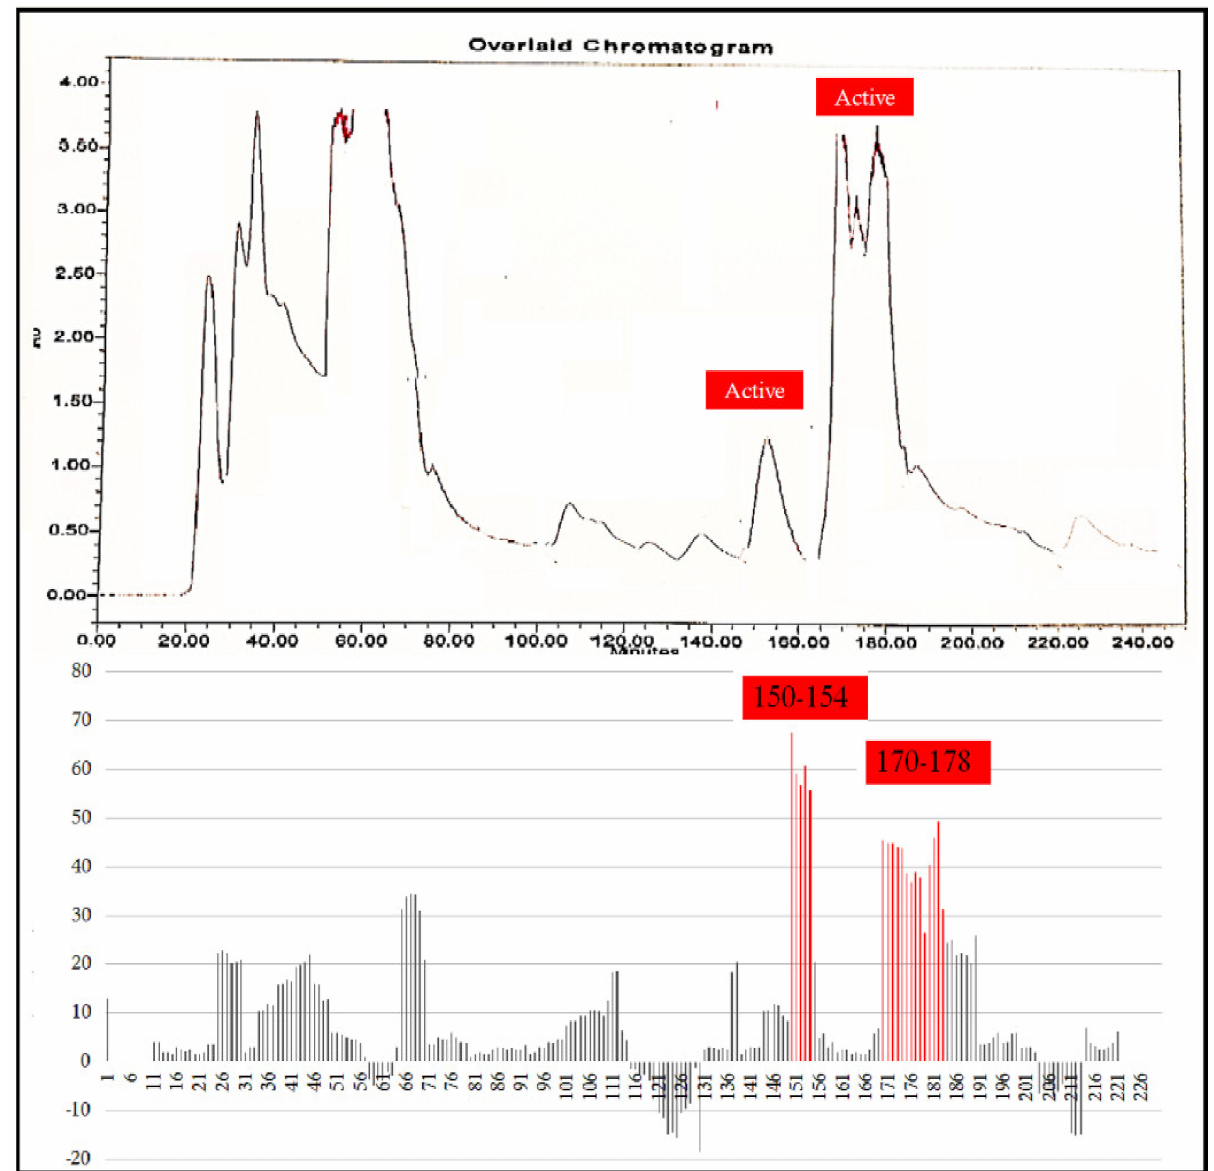
Figure 6. Top panel: Overlaid chromatogram of Ethanol extract of B. biternata leaves; percentage inhibition of obtained fractions against cervical cancer cells (Hela) (bottom